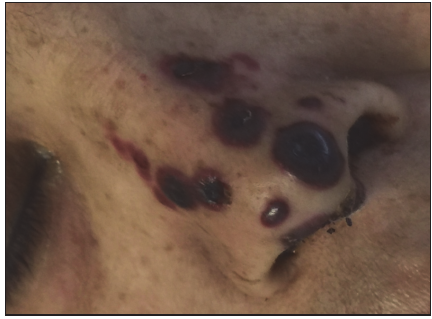
Figure 1: Image depicting severe end arteriolar embolic phe- nomenon to the nose.